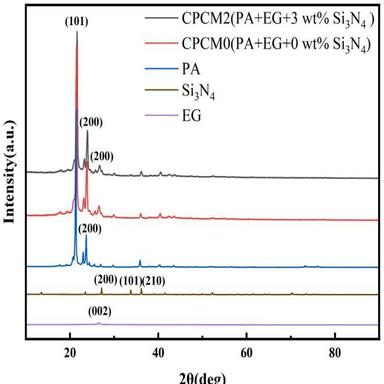
XRD patterns of PA, EG, Si3N4 and CPCMs.